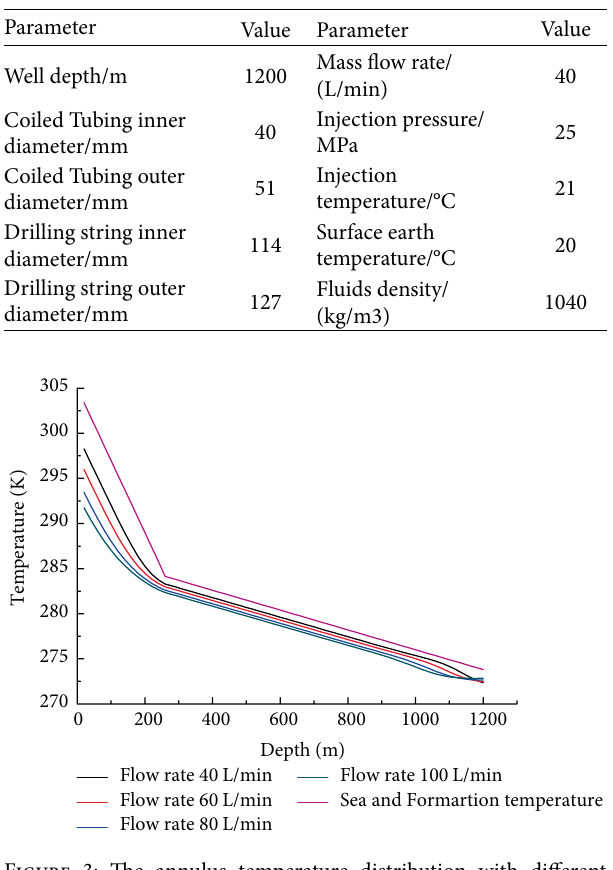
Figure 3: The annulus temperature distribution with different injection rate.